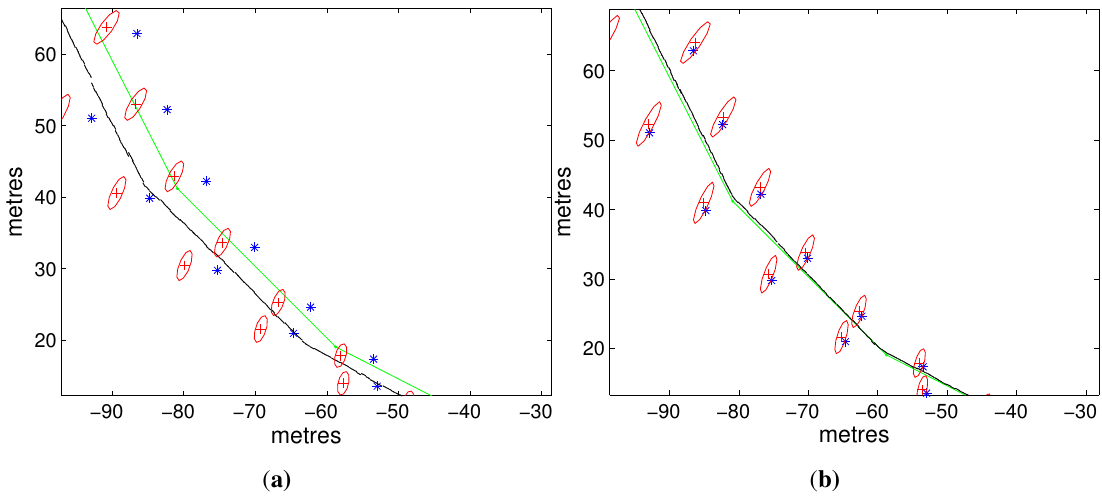
Figure 3. The enlarged portions of the local map, in which ( a ) is for SEIF and ( b ) is for